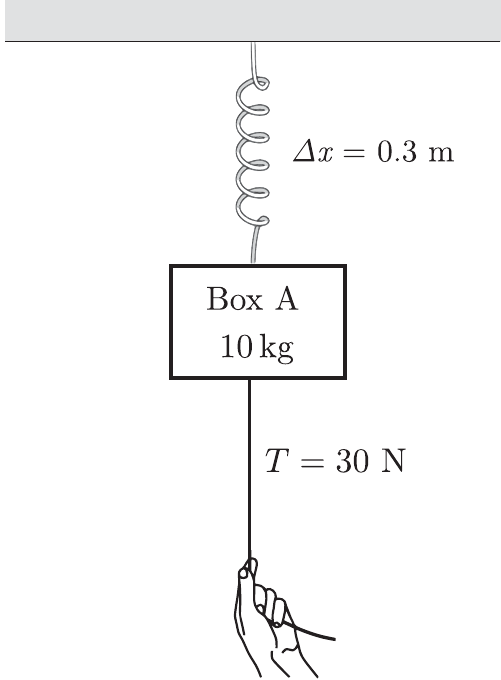
FIG. 2. The second of three questions in the pre- and post-test for this experiment. The first question posed on the test is the screening question shown in Fig. 1(a) and the third question is the target question shown in Fig.